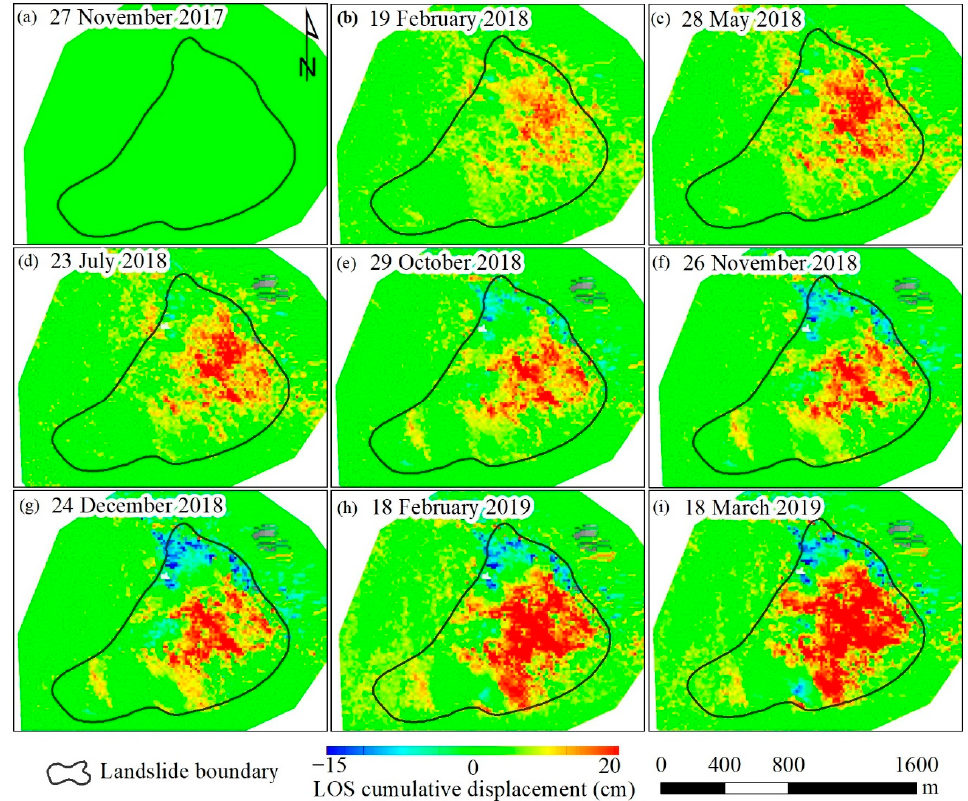
Figure 11. SBAS-based time-series displacement on the landslide from 27 November 2017 to 18 March 2018. ( a – i ) Cumulative deformation of the landslide at nine time points since 27 November 2017.